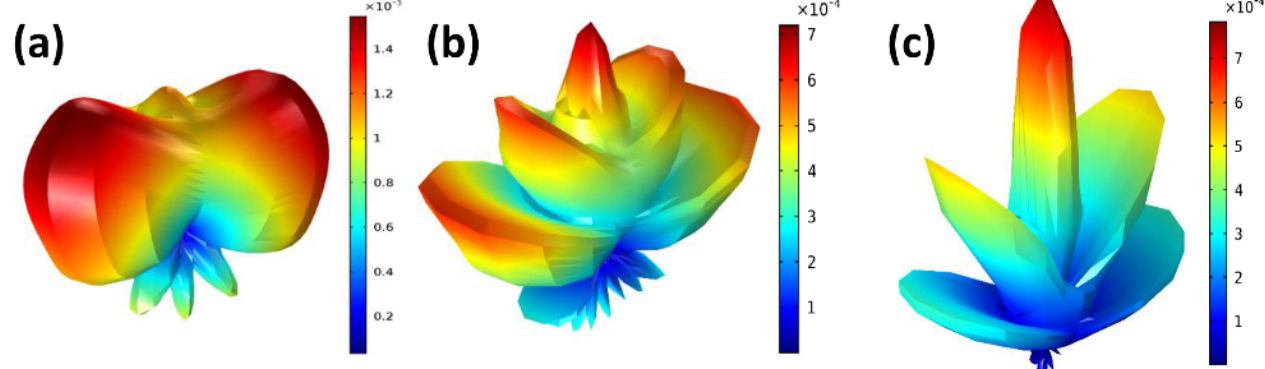
Figure 2. The far − field intensity distributions of a single ( a ) disk (radius r = 50 nm and thickness h = 30 nm), ( b ) circular hole (radius r = 50 nm and thickness h = 30 nm), ( c ) bowtie nanohole (arm length L = 65 nm, taper angle α = 50°, connected spacing d = 20 nm and thickness h1 = 30 nm) placed upon the silica (h2 = 30 nm) and silver film (h3 = 30 nm).